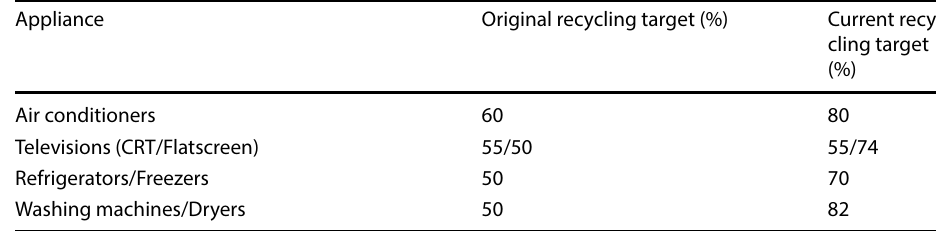
Table 4 Japanese Home Appliance Act recycling targets